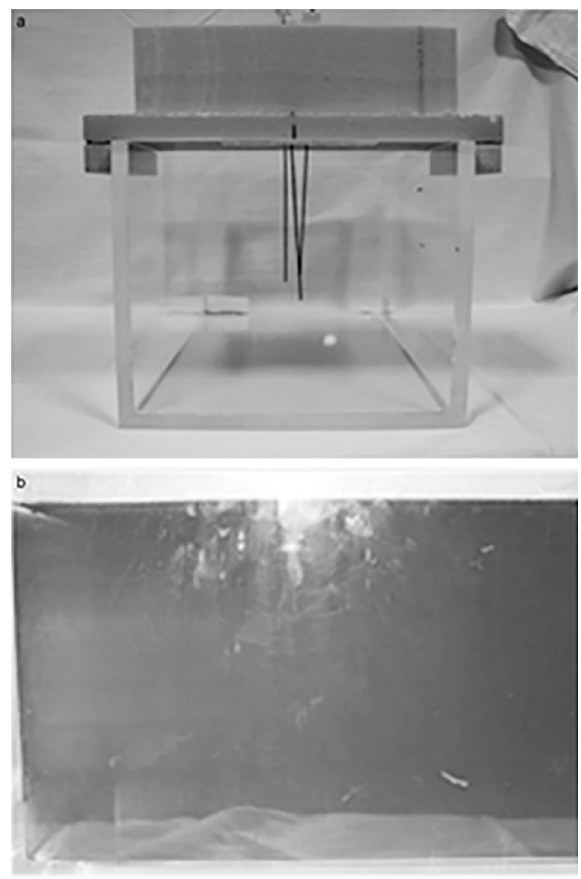
Figure 2. ( a ) Perspex box for the phantom with rigid foam plate to guide needles with gold seeds for reproducibility ( b ) phantom contained within perspex